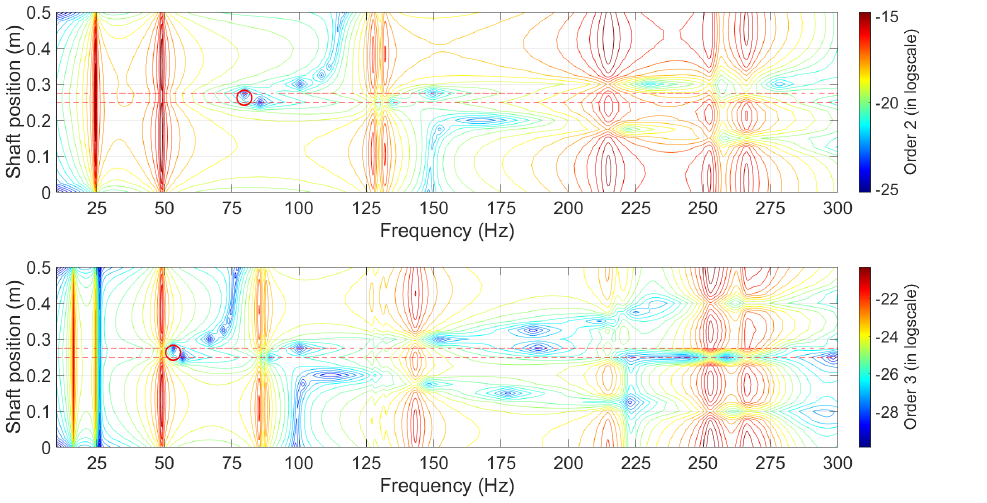
Figure 6. Case 2—Identification of the crack location based on the antiresonances of orders 2 and 3 (results are drawn for the vertical amplitudes in